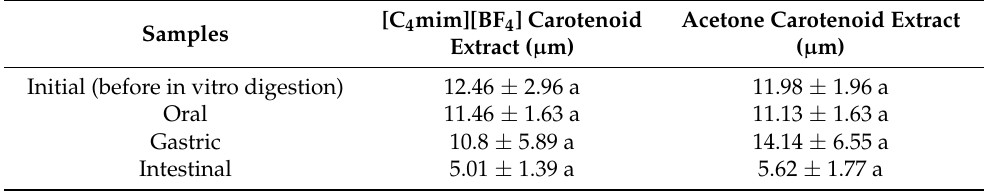
Figure 3. Bioaccessibility of carotenoids from peach palm fruits. Data represent the percentage of carotenoids incorporated into mixed micelles after in vitro digestion. Different letters above each carotenoid bar correspond to a significant difference between the [C 4 mim][BF 4 ] and acetone extracts. t -test and Dunn test for means comparison were carried out. Table 2. Microstructure values ( µ m) of the emulsions produced with both extracts (ionic liquid [C 4 mim][BF 4 ], and acetone), and their respective values in each phase of the simulated digestion process (oral, gastric, and